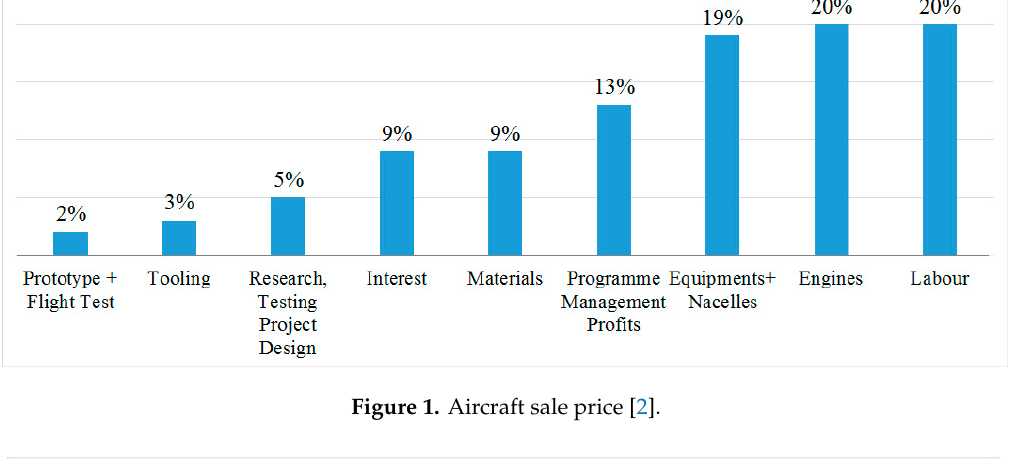
Figure 1. Aircraft sale price [2].